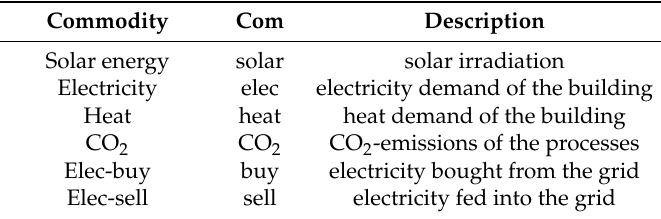
Table 5. Commodities implemented in URBS.